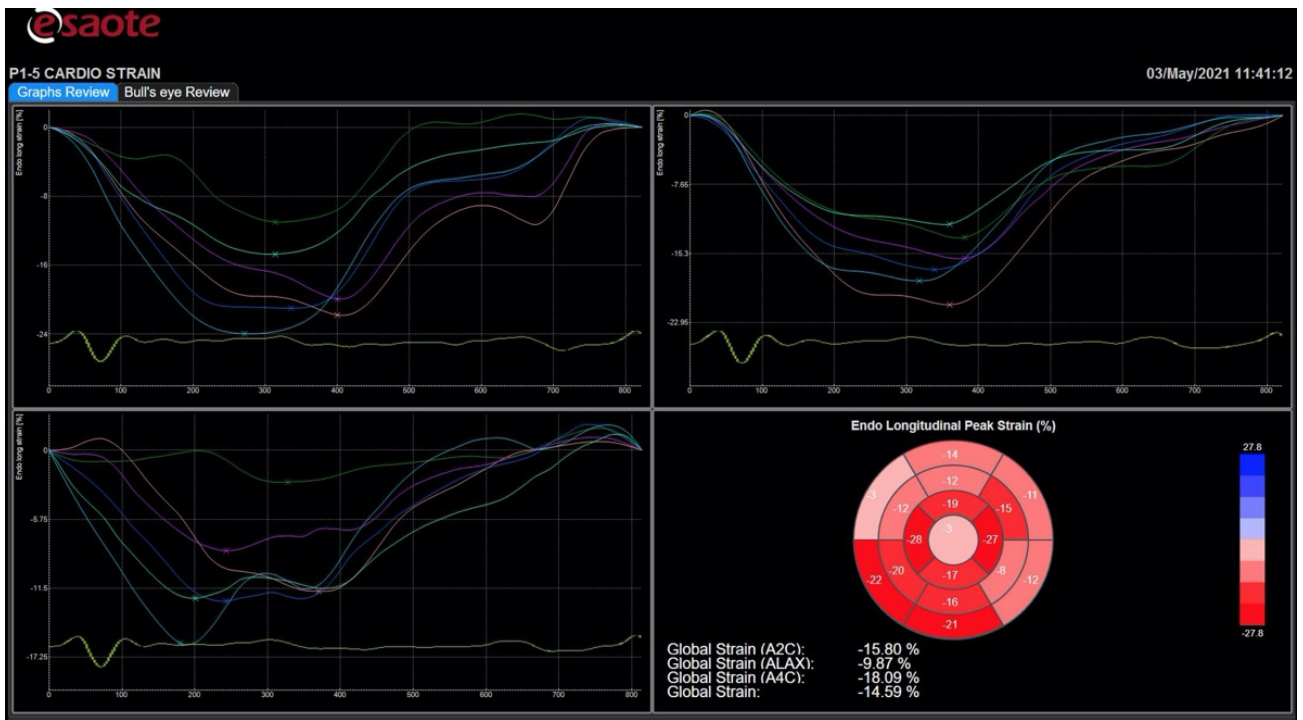
Figure 1. Strain curves and bull’s eye in a patient with heart failure and reduced ejection fraction. Scheme 3. 4-, and 2-chamber views are not homogeneous, indicating that left ventricular segments do not contract all at the same time, and also the degree of systolic shortening is greater in some segments and impaired in others. At the bottom right, the bull’s eye displays a reduced value of global longitudinal strain. All images were obtained using an Esaote Mylab echo-scanner.